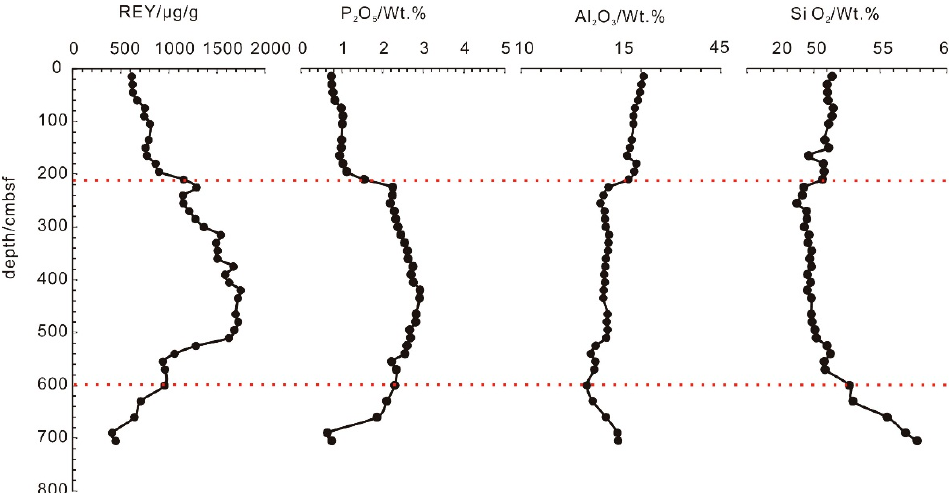
Figure 9. Variations in REY, P 2 O5, SiO 2 , and Al 2 O 3 contents in core P10.